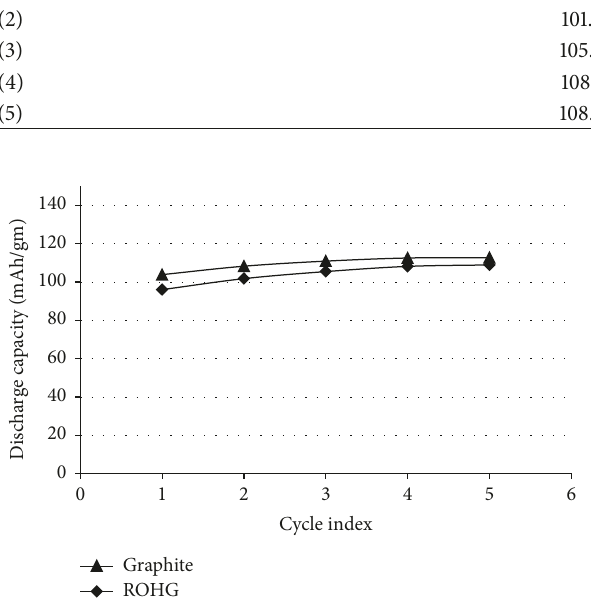
Figure 3: Weight normalized discharge capacity for conditioning cycles as a function of cycle index. Figure 4: Efficiency (%) data of graphite and ROHG as a function of conditioning